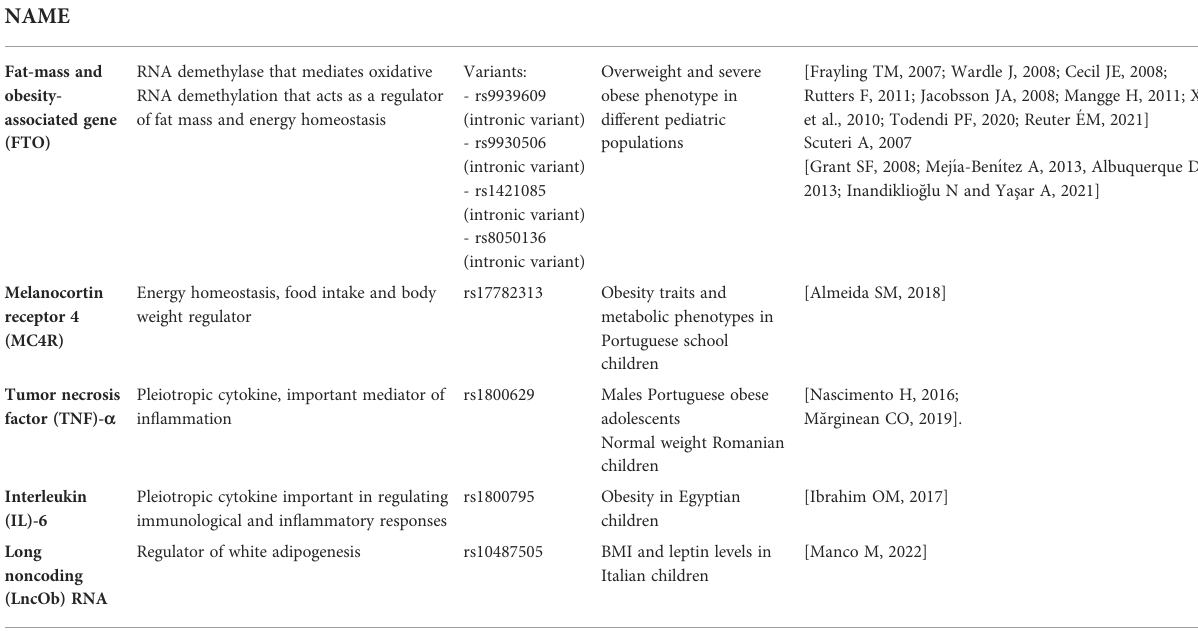
TABLE 2 Genetic determinants of polygenic obesity in